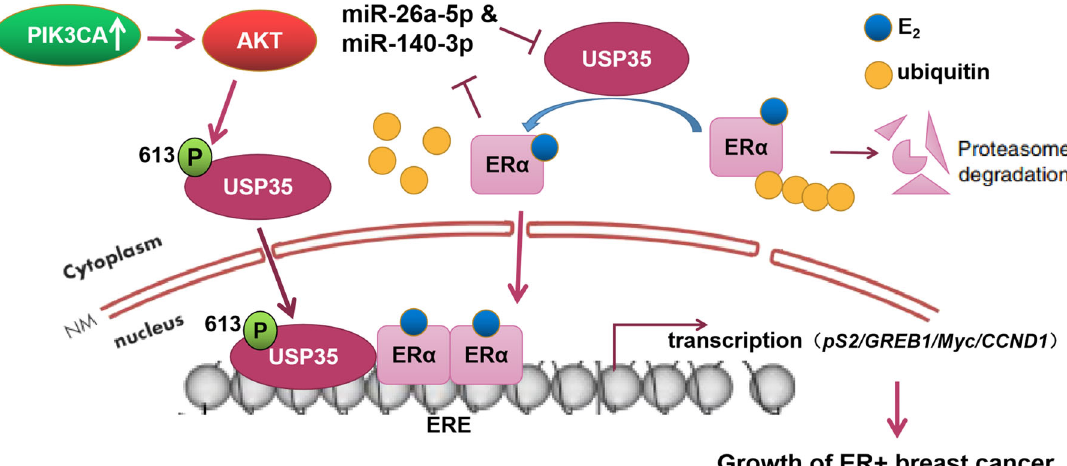
Fig. 7 A working model of USP35 action in ER positive breast cancer. USP35 promotes ER α stabilization via deubiquitinating ER α . In addition, AKT phosphorylates USP35 at Ser613, which promotes USP35 nuclear localization, enhancing ER α transcriptional activity. Estrogen increases USP35 expression through inhibiting miR-26a-5p and miR-140-3p expression. This positive feedback loop promotes ER + breast cancer